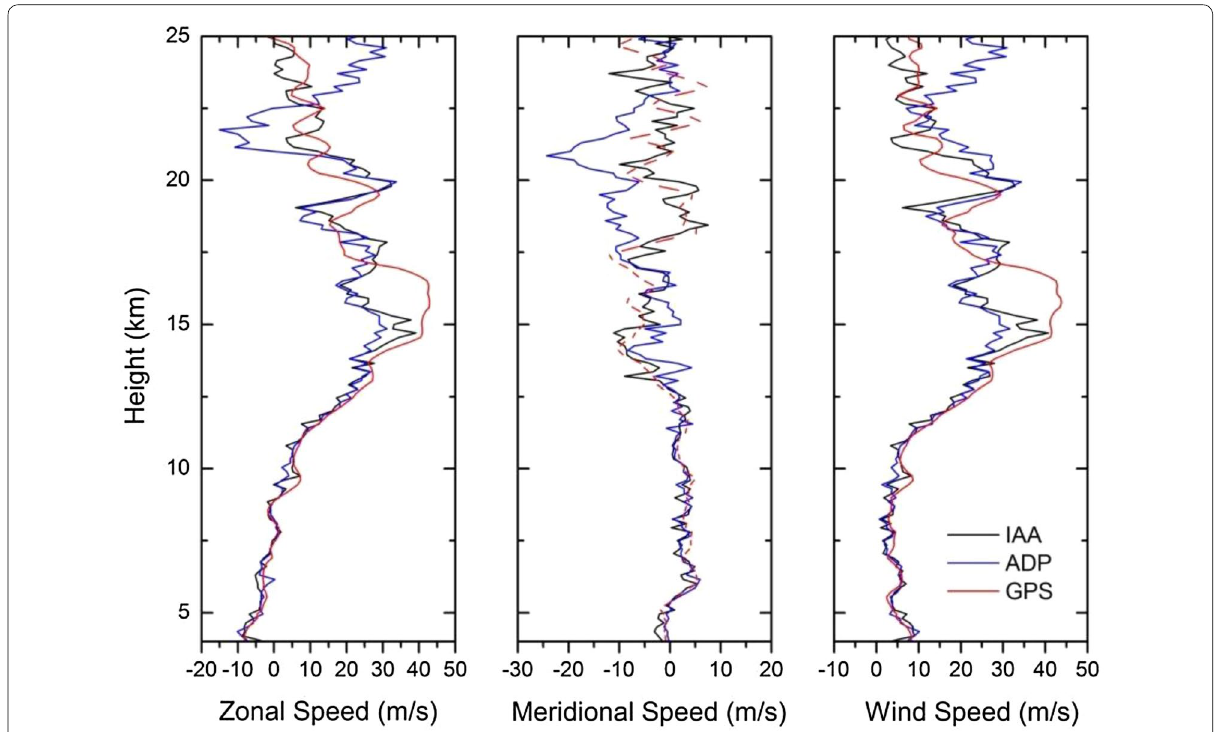
Fig. 6 Zonal, Meridional and Wind Speed for June 9, 2006 data using ADP, IAA and GPS